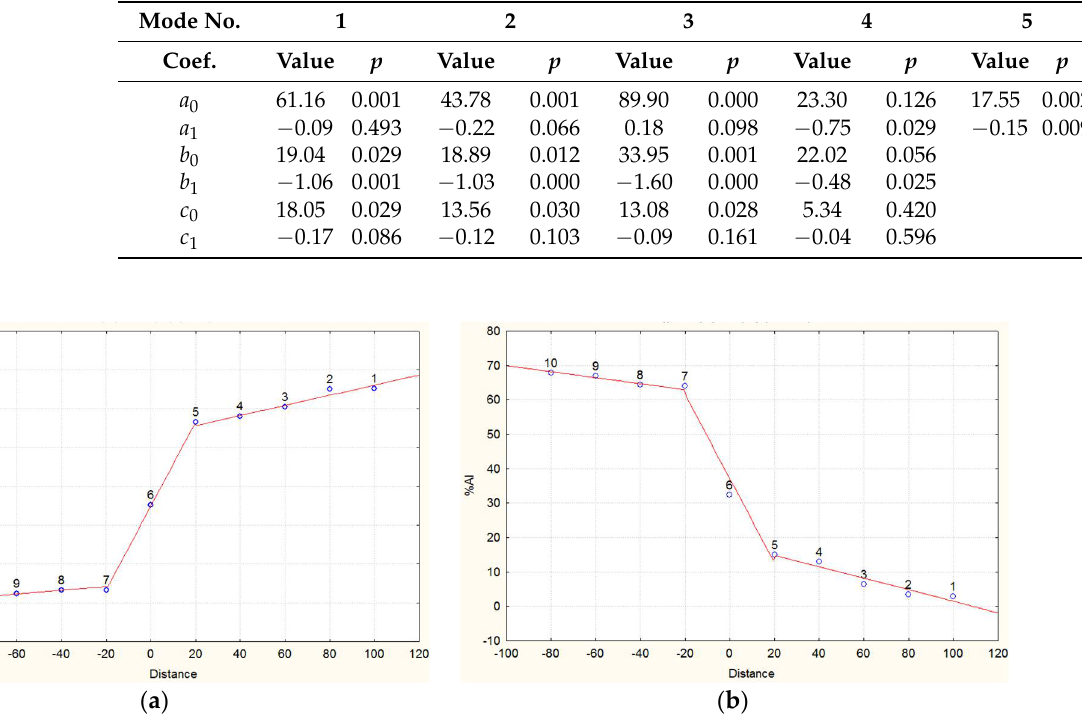
Figure 7. Piecewise linear approximation of Fe ( a ) and Al ( b ) content in the bimetal interface (SLM mode 2). The microhardness in the interface region had a gap; therefore, the experimental re-